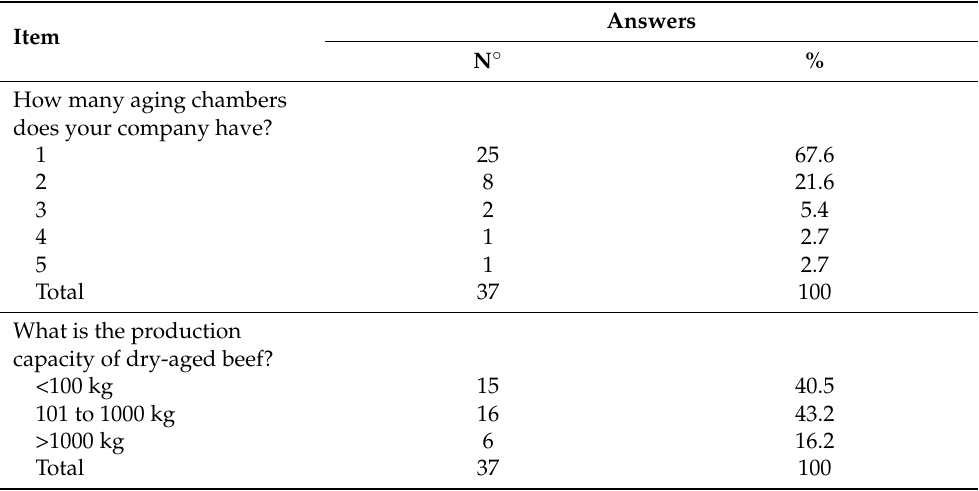
Table 2. Production capacity of dry aging producers in Brazil in 2019.